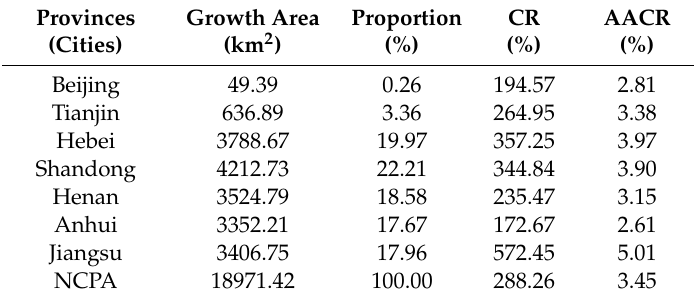
Figure 6. The occupation ratio ( OR ( i ) ) of the built-up land in floodplains of each district and county in Figure 7. The occupation ratio (OR (i) ) of the built-up land in floodplains of each district and county 2014. in 2014. Table 2. The rapid growth of built-up land in floodplains from 1975 to